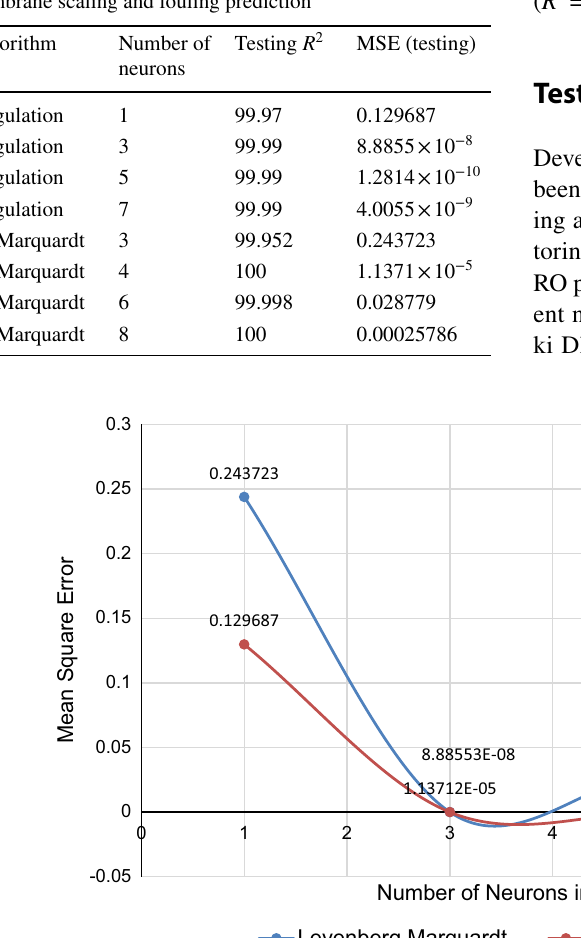
Fig. 8 Mean square error variation with the number of neurons in hidden